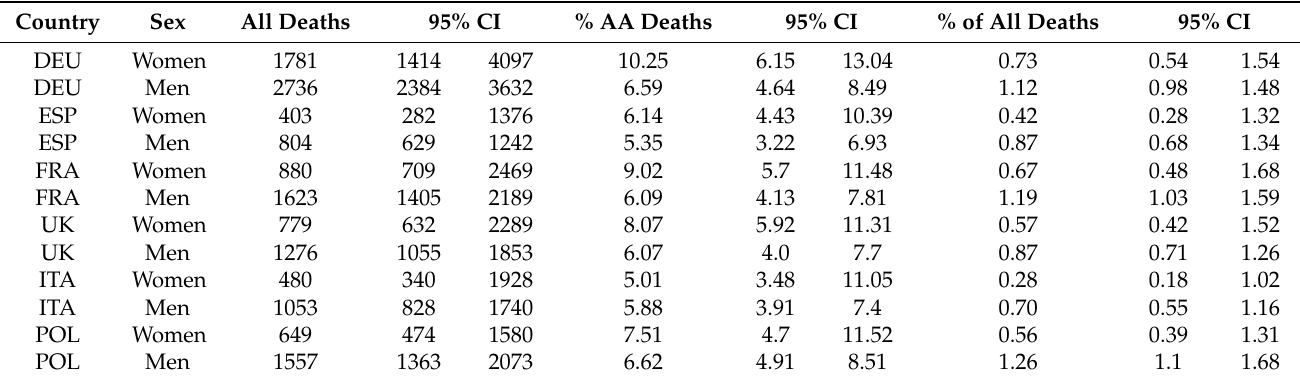
Table 1. Potential averted deaths due to a reduction of alcoholic strength in